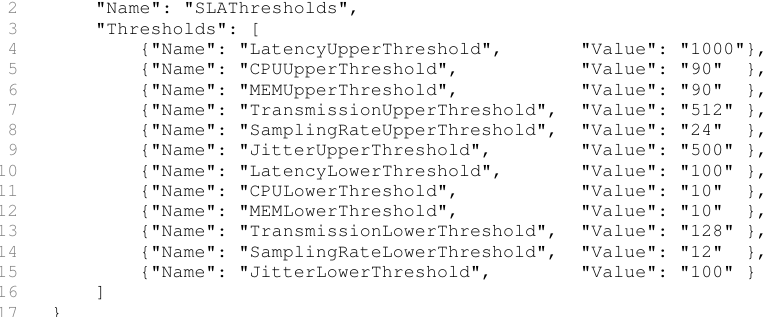
Figure 9. SLA file containing the default values for each threshold used in the Orchestration Engine